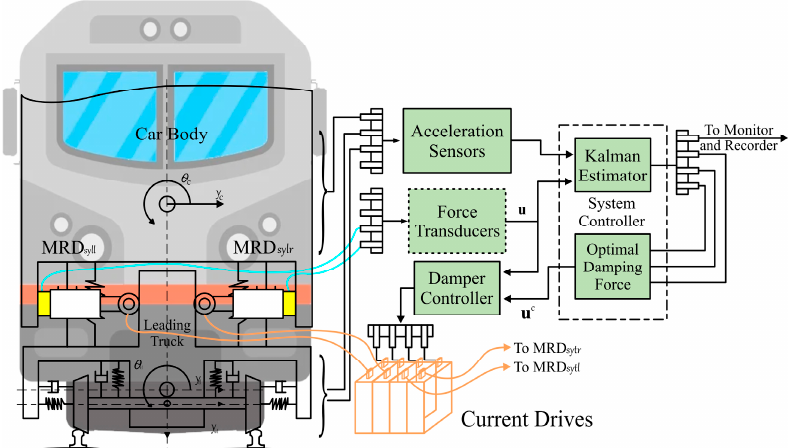
Figure 12. Schematic of a railway vehicle integrated with the semi ‐ active controlled secondary suspension system based on magnetorheological dampers [158].